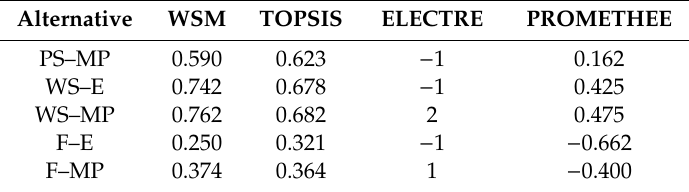
Table 4. Scores (equal weighted) of wood-based residential heating alternatives obtained through application of: (i) WSM, (ii) TOPSIS, (iii) ELECTRE, and (iv) PROMETHEE.